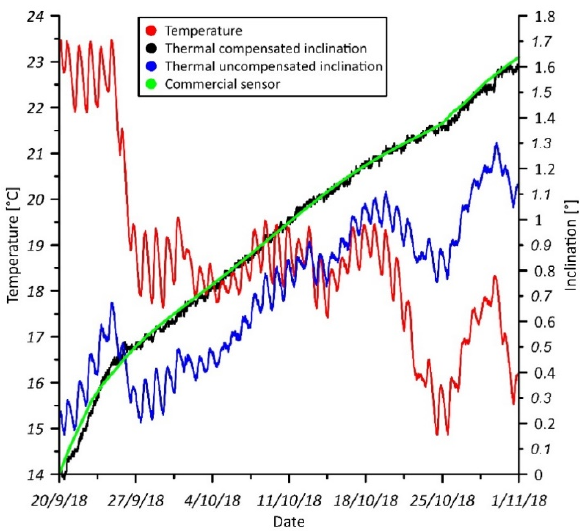
Figure 4. Graph showing monitoring data registered by the single ‐ module prototype and the commercial sensor. The red, blue, and black lines represent the data registered by the single ‐ module prototype, while the green line represents the inclination measured by the commercial sensor.